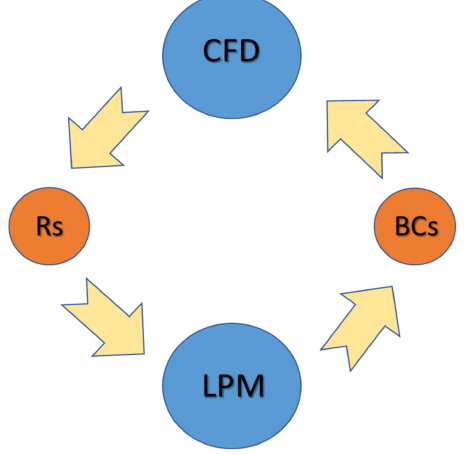
Figure 10. 3D CFD to 0D LPM coupling